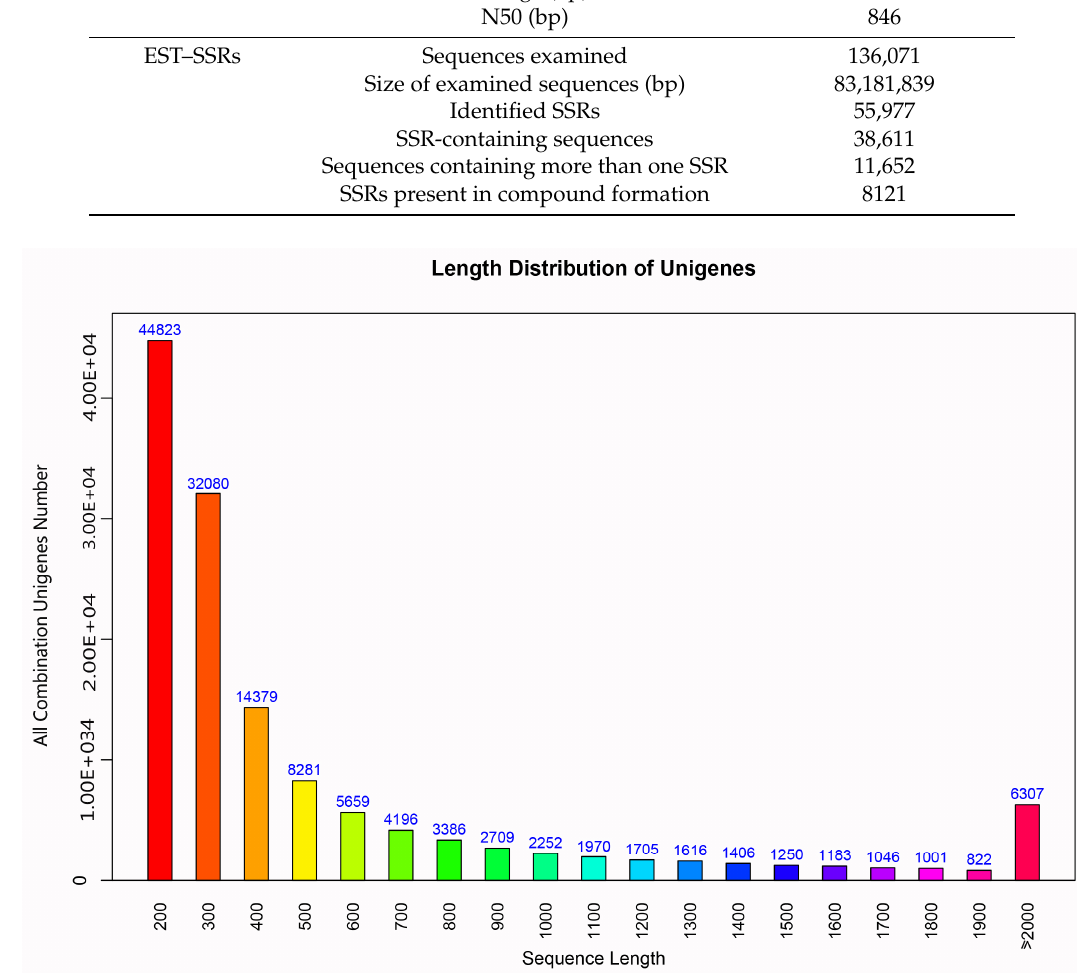
Figure 1. Length distribution of unigenes. Horizontal and vertical axes show the size and number of unigens, respectively. What is counted is the number of the unigenes with the length of over 200 bp. The statistics of unigenes equal to or more than 2000 bp are classified as a group. The number of unigenes with different length ranges is indicated by columns with different colors.